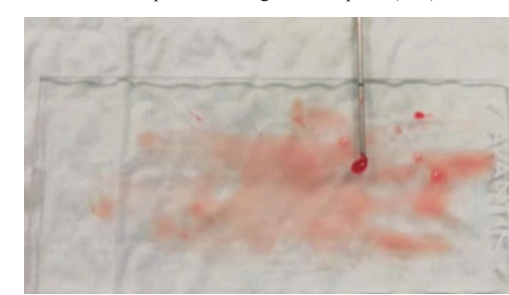
Figure 23 Excessive press resulting in cell rupture (×10).